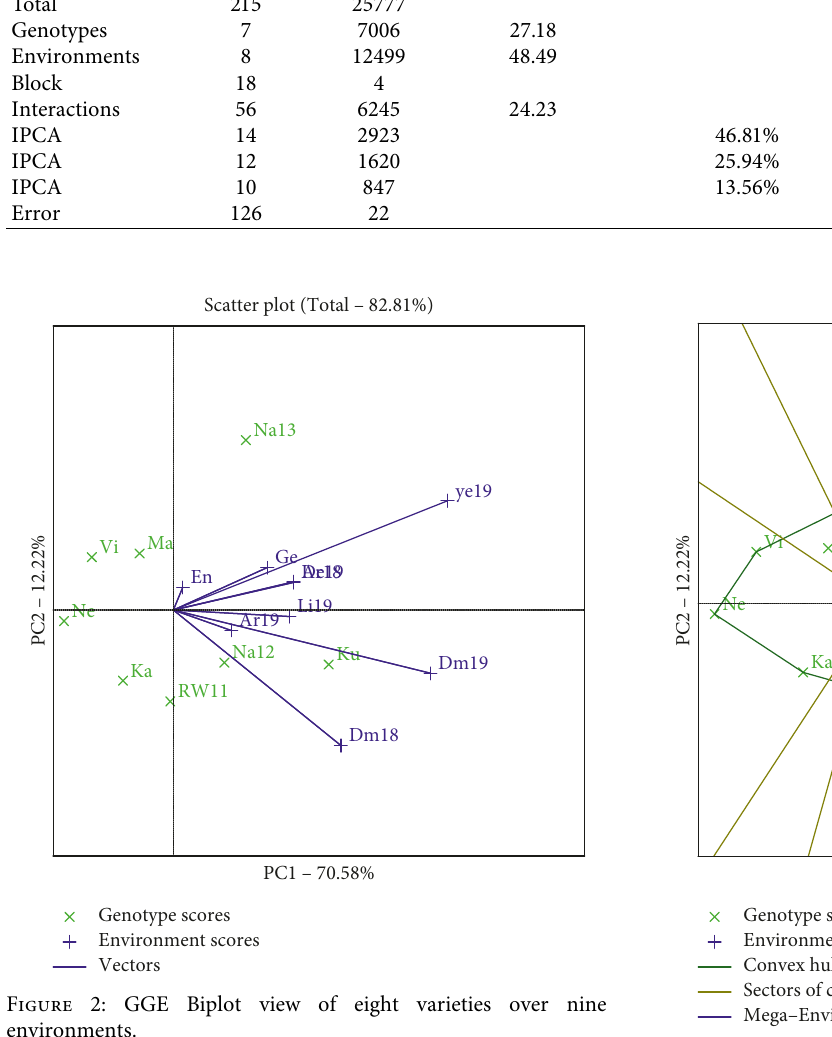
Figure 3: Which-won-where view of eight OFSP varieties over nine environments.